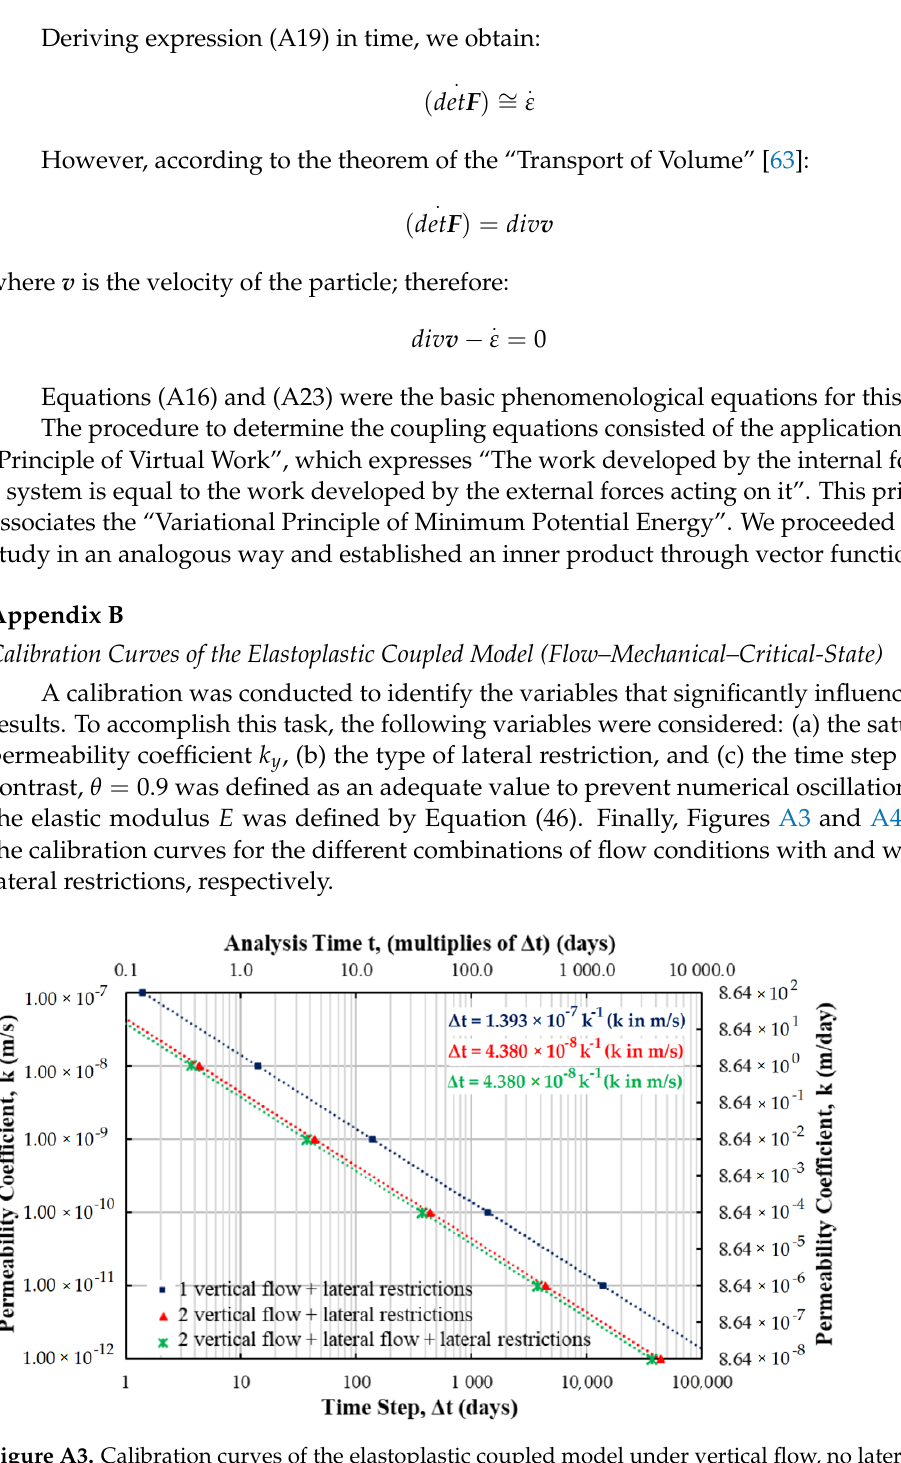
Figure A3. Calibration curves of the elastoplastic coupled model under vertical flow, no lateral flow, and lateral restraints. When analyzing the results obtained from the simulations and as shown in Figure A3, the dependence of the time step ∆𝑡 and analysis time 𝑡 on the permeability coeffi- cient 𝑘 was evident. For example, for 𝑘 = 8.64𝑥10 (cid:2879)(cid:2872) 𝑚 𝑑𝑎𝑦⁄ ( 𝑘 = 1𝑥10 (cid:2879)(cid:2876) 𝑚 𝑠⁄ ), the time step should be ∆𝑡 = 13.93 𝑑𝑎𝑦𝑠 , and the minimum analysis time should reach 𝑡 = 139.3 𝑑𝑎𝑦𝑠 . Thus, if the permeability were reduced 10 times; i.e., for 𝑘 = 8.64𝑥10 (cid:2879)(cid:2873) 𝑚 𝑑𝑎𝑦⁄ , the time step should have been increased by the same order; i.e., ∆𝑡 = 139.3 𝑑𝑎𝑦𝑠 , and the minimum analysis time should have been 10 times longer ( 𝑡 = 1393 𝑑𝑎𝑦𝑠 ) to ensure that the pore pressure dissipated to zero. Three equations represent- ing the model calibration curves for the different vertical flow conditions without lateral flow and with lateral restrictions are shown in Figure A1. ∆𝑡 = (cid:2869).(cid:2871)(cid:2877)(cid:2871)(cid:3051)(cid:2869)(cid:2868) (cid:3127)(cid:3123) (cid:3038)((cid:3036)(cid:3041) (cid:3040) (cid:3046)⁄ (cid:4667) one vertical flow, no lateral flow, lateral restrictions (76) ∆𝑡 = (cid:2872).(cid:2871)(cid:2876)(cid:2868)(cid:3051)(cid:2869)(cid:2868) (cid:3127)(cid:3124) (cid:3038)((cid:3036)(cid:3041) (cid:3040) (cid:3046)⁄ (cid:4667) two vertical flows, no lateral flow, lateral restrictions (77) ∆𝑡 = (cid:2871).(cid:2875)(cid:2871)(cid:2868)(cid:3051)(cid:2869)(cid:2868) (cid:3127)(cid:3124) (cid:3038)((cid:3036)(cid:3041) (cid:3040) (cid:3046)⁄ (cid:4667) two vertical flows, no lateral flow, lateral restrictions